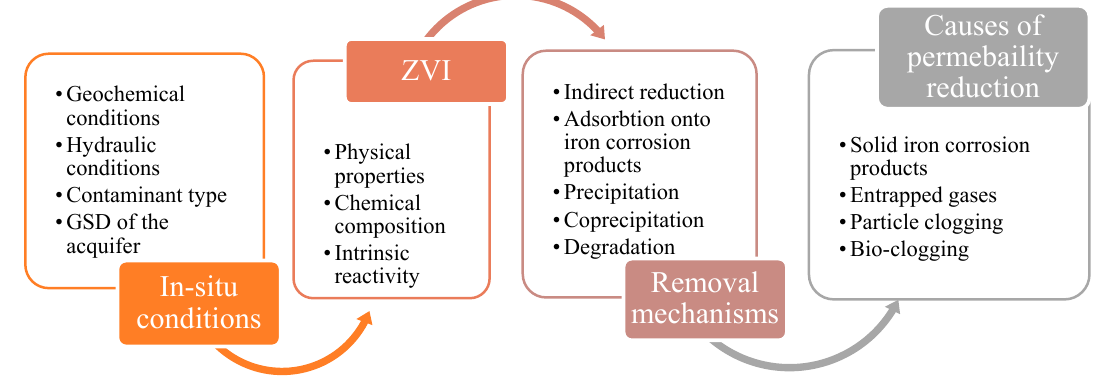
Figure 3. The factors that influence the long-term behavior of ZVI-based